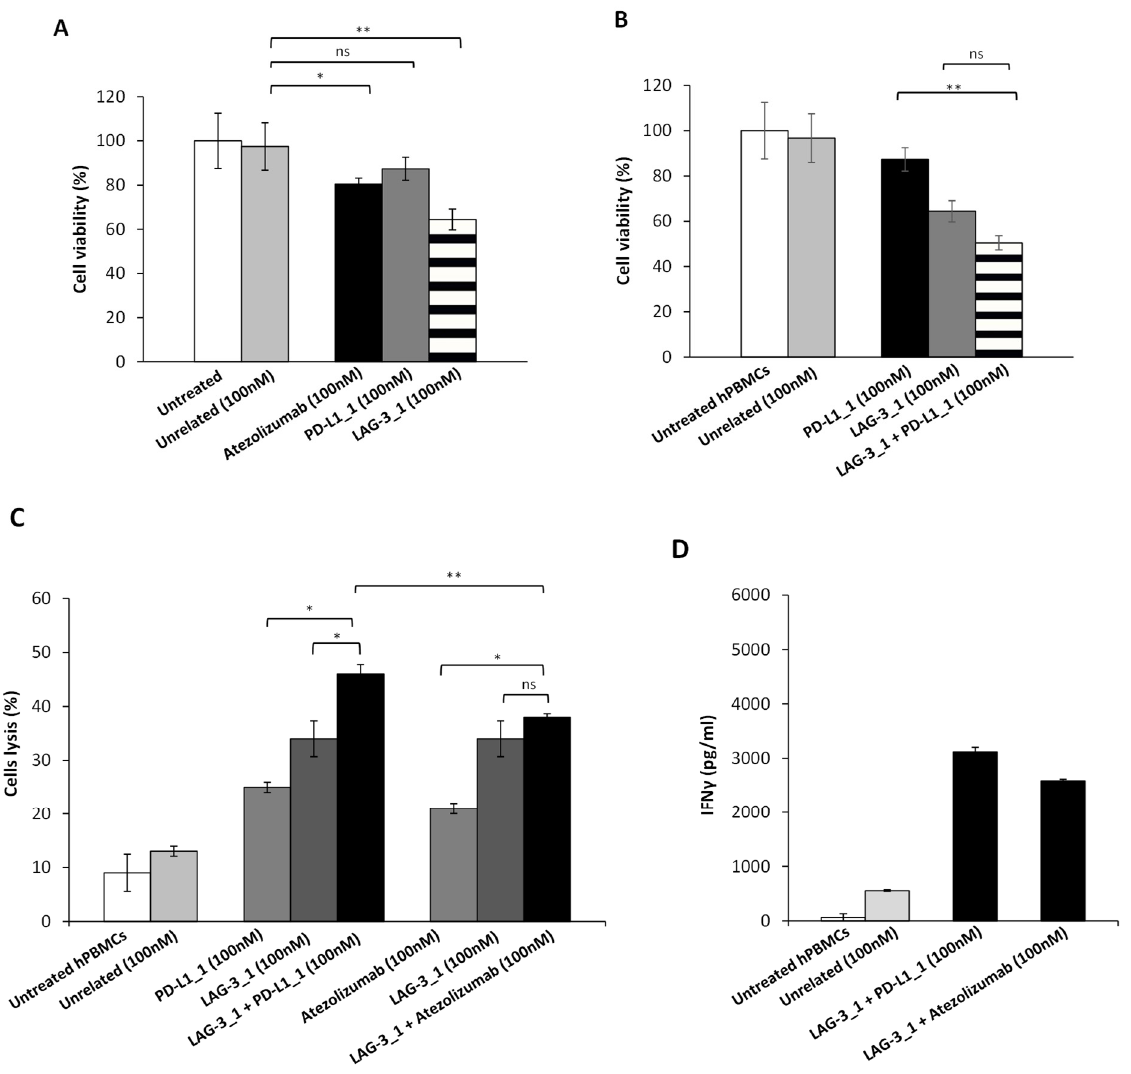
Figure 8. Effects of novel immunomodulatory mAbs on viability of HuT-78 tumor cells in the absence of lymphocytes. ( A , B ) MTT assays were performed on the supernatant of HuT-78 tumor cells, treated for 72 h with anti-PD-L1 or anti-LAG-3 mAbs, used as single agents or in combinatorial treatments. Cell viability is expressed as percentage of viable cells with respect to control untreated ones. Error bars depict means ± SD ** p < 0.01; * p < 0.05. ( C ) LDH levels were detected in the supernatant of HuT-78 tumor cells co-cultured with hPBMCs (Effector:Target cells ratio 5:1), treated for 48 h with anti-PD-L1 or anti-LAG-3 mAbs, or their combination, at the indicated concentrations. ( D ) Levels of IFN- γ secreted by hPBMCs co-cultured with tumor cells and treated with anti-CTLA-4, anti-PD-L1, or anti-LAG-3 mAbs, or their combination, at the indicated concentration for 48 h. Cells untreated or treated with an unrelated IgG were used as negative controls. Error bars depict means ± SD. p -values for the indicated compounds are: ** p < 0.01; * p < 0.05. In order to investigate on the effects of anti-PD-L1 or anti-LAG-3 mAbs on HuT-78 in the presence of lymphocytes, we co-cultured tumor cells with hPBMCs (Effector:Target cells ratio 5:1) for 48 h and treated them with atezolizumab, PD-L1_1, LAG-3_1, or their